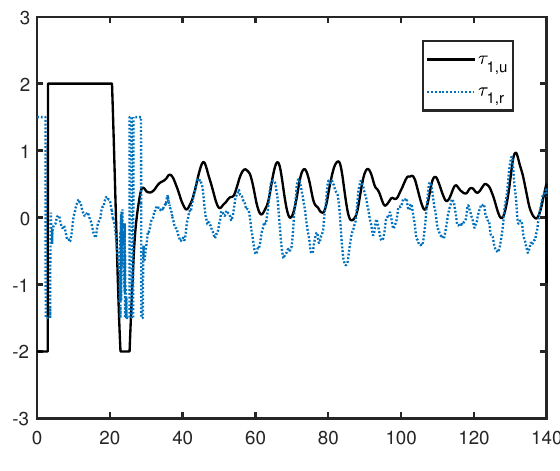
Figure 9. Control input of USV